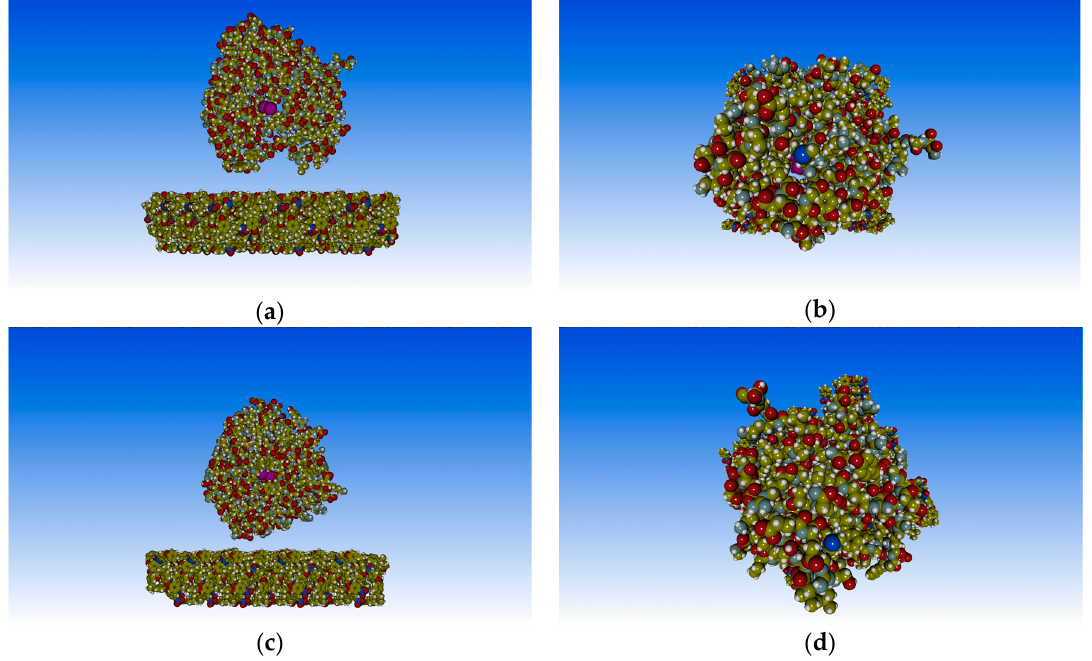
Figure 3. Adsorbed PTE on the PSU model surface in the global minimum ( − 107.96 Kcal/mol at d = 30 Å). ( a ) side view and ( b ) top view of the enzyme surface, respectively; ( c ) side view and ( d ) top view of the full enzyme structure in the same orientation, respectively. Zinc atoms were shown in fuchsia.